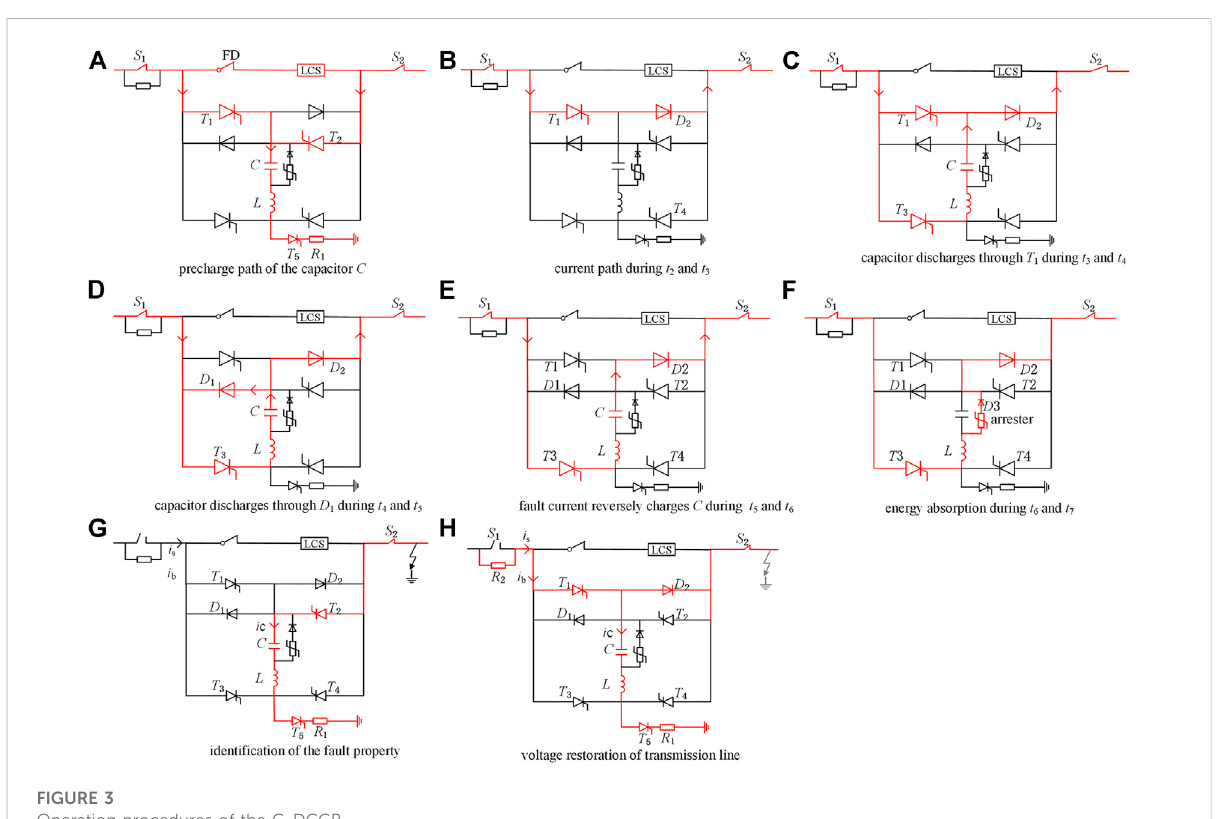
FIGURE 3 Operation procedures of the